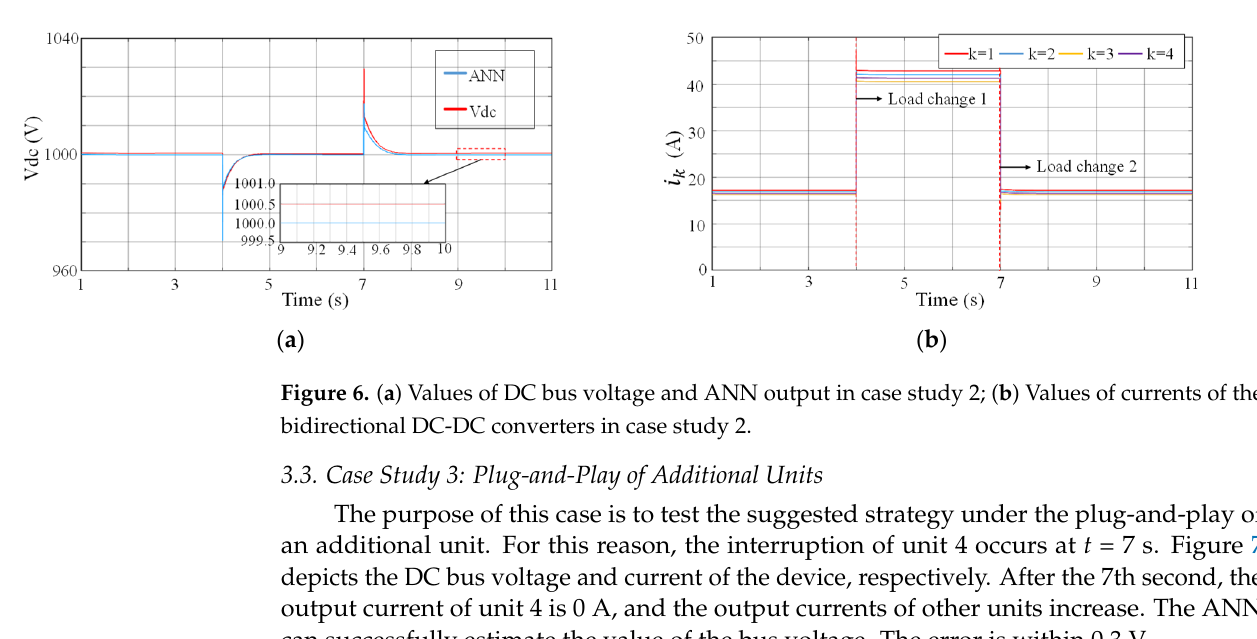
( b ) Figure 7. ( a ) Values of DC bus voltage and ANN output in case study 3; ( b ) Values of currents of the bidirectional DC ‐ DC converters in case study 3. 3.4. Case Study 4: Complex Situations In this case, the suggested method ‐ based ANN will be tested in more complex situa ‐ tions. The shutdown of unit 4 occurs at t = 4 s, and the load is added to the DC microgrid at t = 5 s. As shown in Figure 8. When the DC microgrid operates according to the pro ‐ posed strategy, the ANN can still accurately estimate the bus voltage value, even if the system is in a state of a large load change or unit outage. The enlarged view of Figure 8a shows that the error in a steady state is less than 0.3 V.